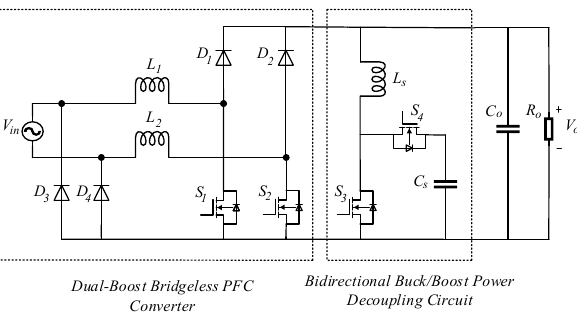
Figure 1. Dual-boost bridgeless PFC converter based on power decoupling.